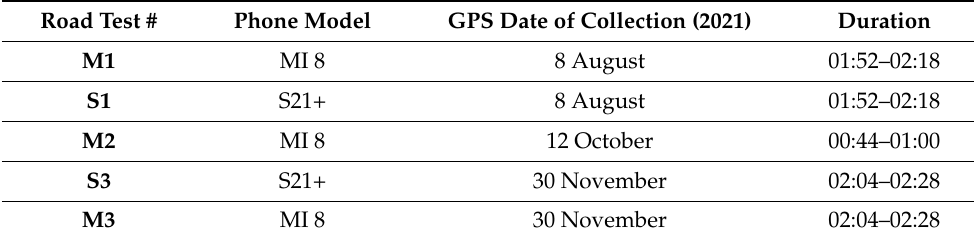
Table 9. Summary of all road tests.